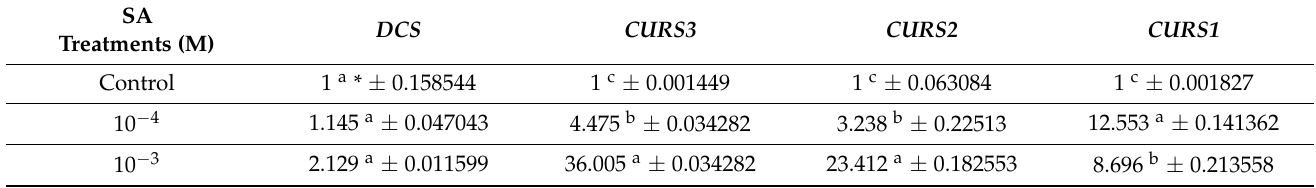
Table 11. Differential expression profiling of the curcuminoid synthase genes, CURS1 , CURS2 , CURS3, and DCS , in C. longa rhizomes from control- and SA (10 − 4 and 10 − 3 M)-treated plants. Data were normalized using Actin as an internal reference gene.